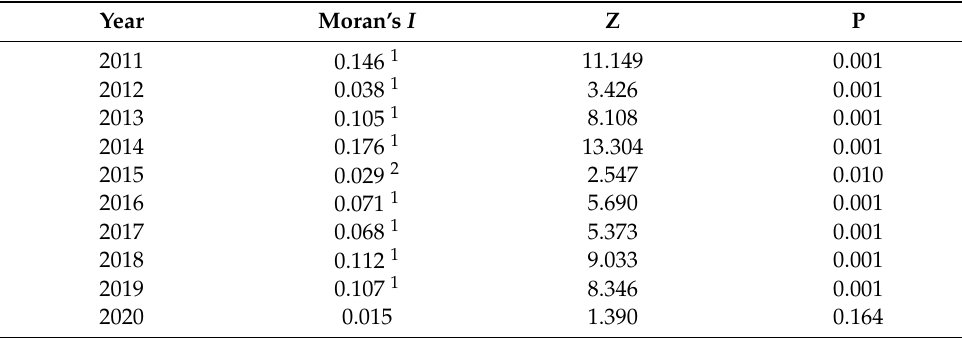
Table 4. Spatial autocorrelation test of agricultural Tfpch.